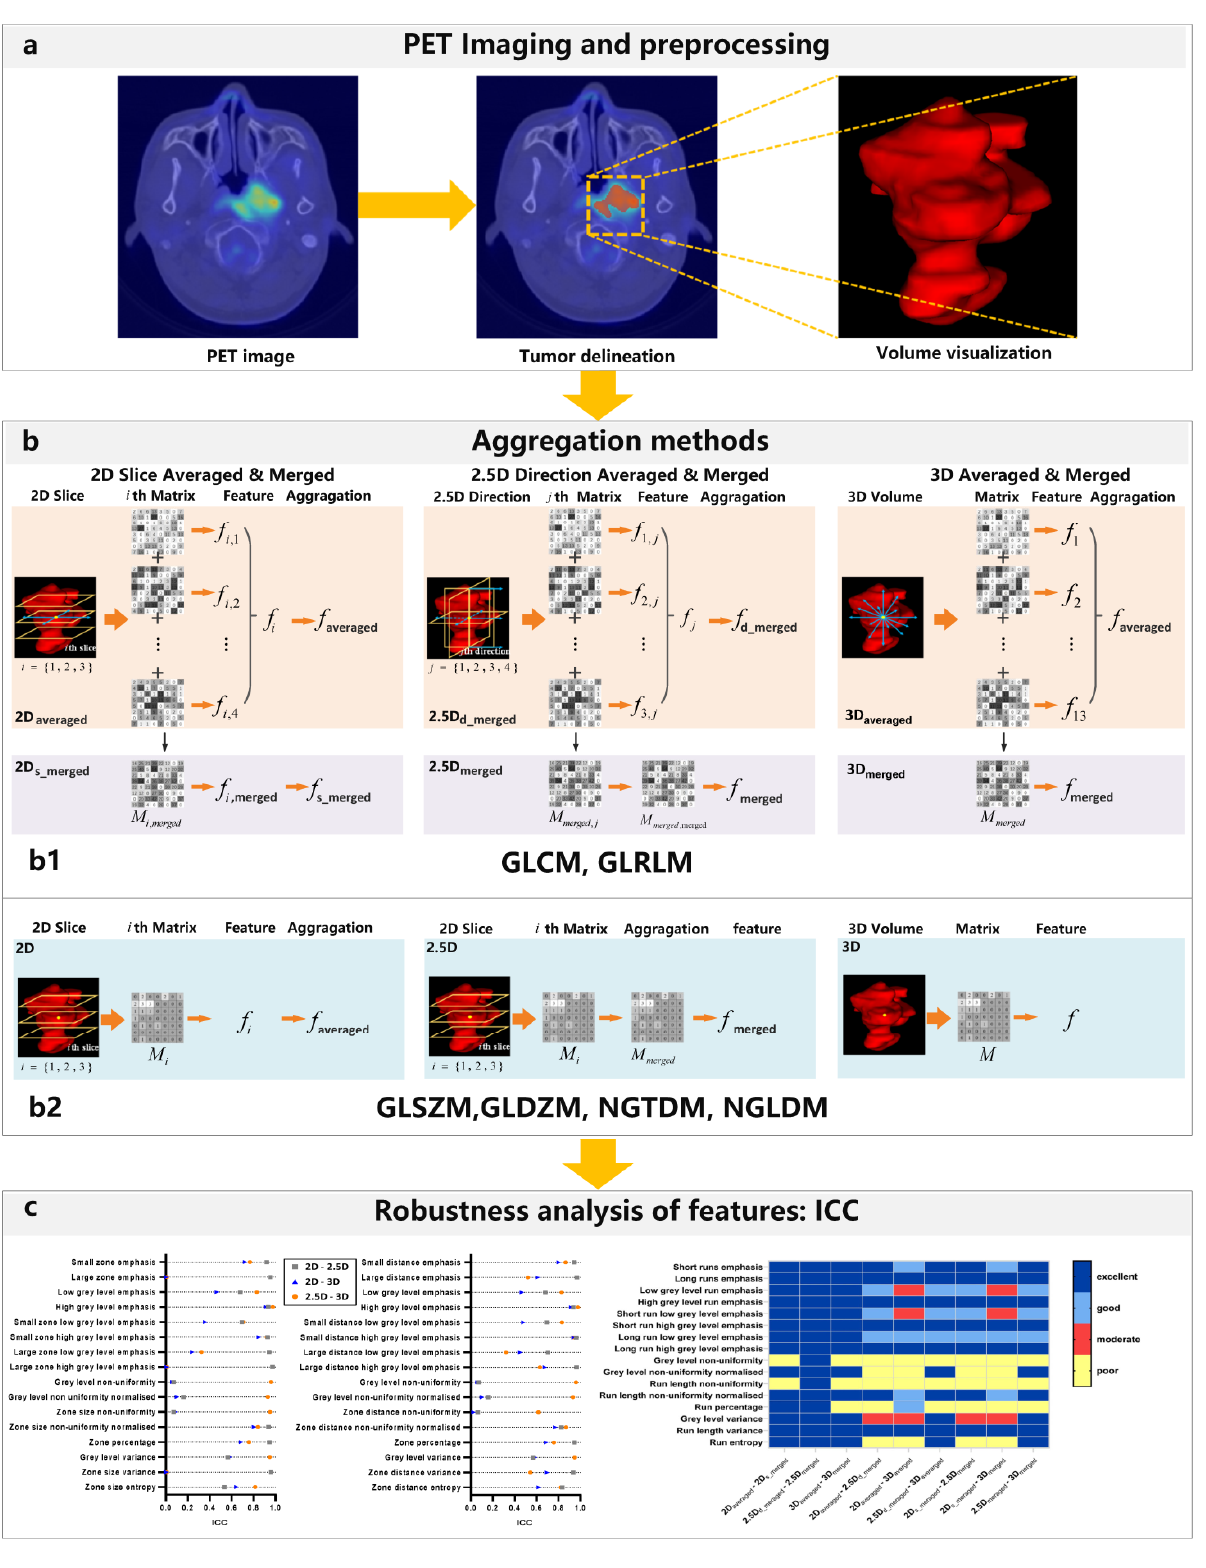
Figure 1. The flowchart of the present study includes PET imaging and processing, aggregation meth- ods, and the robustness analysis of features. ( a ) Illustration of PET/CT imaging of